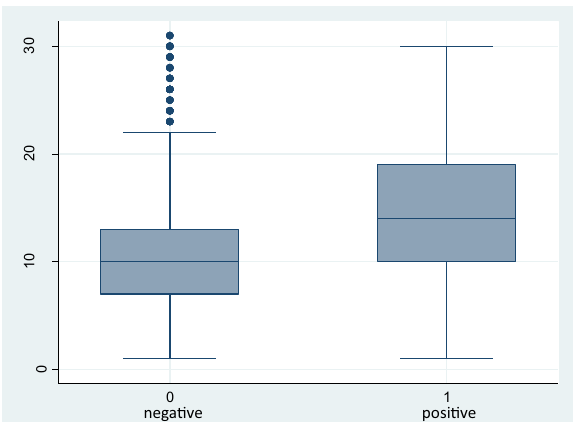
Figure 2. Box-plot analysis of numbers of swabs performed in negative (0) and positive (1) workers. Data are reported as median, 25°–75° percentile, minimum and maximum and